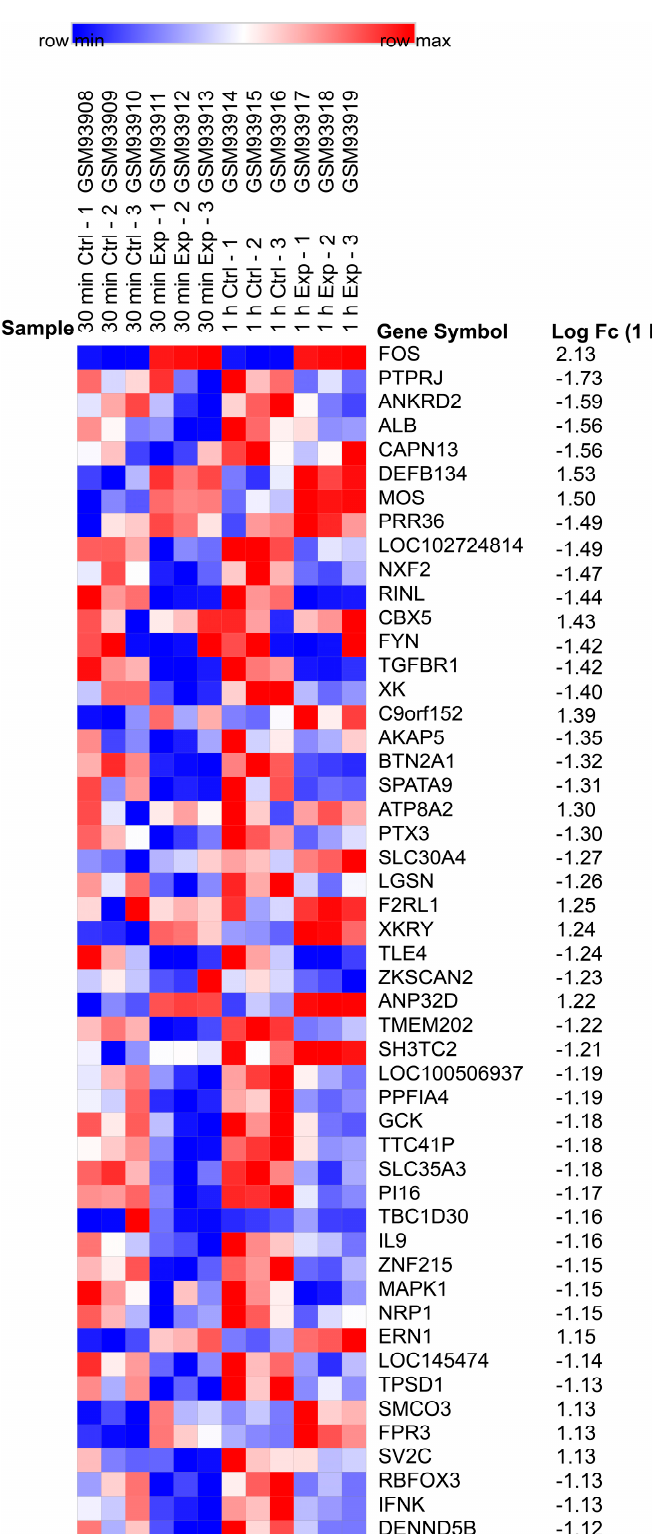
Figure 2. Heat map of the top 50 differentially expressed genes (DEGs). These genes were selected in descending order of their absolute values of LogFC of DEGs. Data from Jurkat cells treated with nanosecond pulsed electric field (nsPEF) for 60 min were shown.